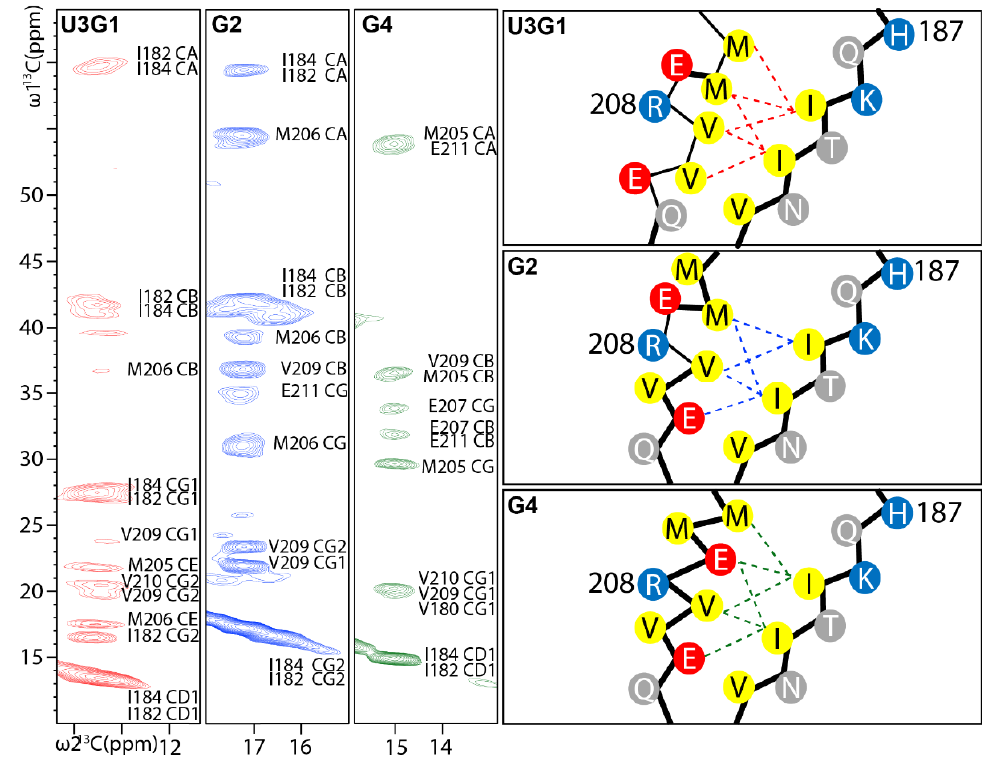
Figure 5. Isoleucine methyl group region of the C(HH)C spectra (mixing time 0.3 ms) of MoPrP(89- 230) U3G1 (red), G2 (green) and G4 (blue) condition fibrils. The observed contacts are illustrated on structural models (on the right) created by taking into account the secondary structure information, with beta strands indicated by bold lines.